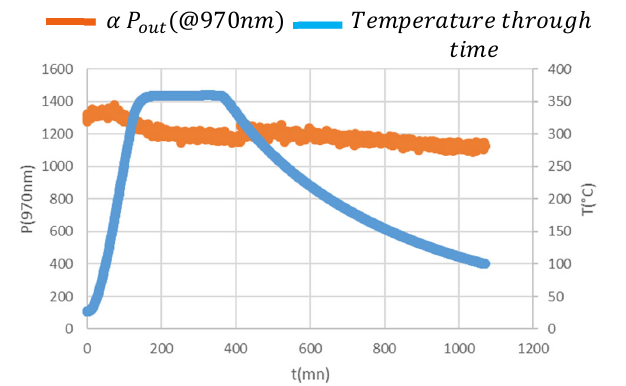
Figure 3: Stability of RIA setup with temperature